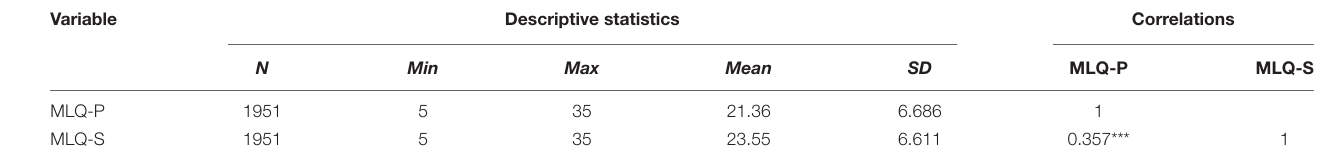
TABLE 1 | Minimums, maximums, means, standard deviations (SD), and bivariate correlations among the four dimensions.